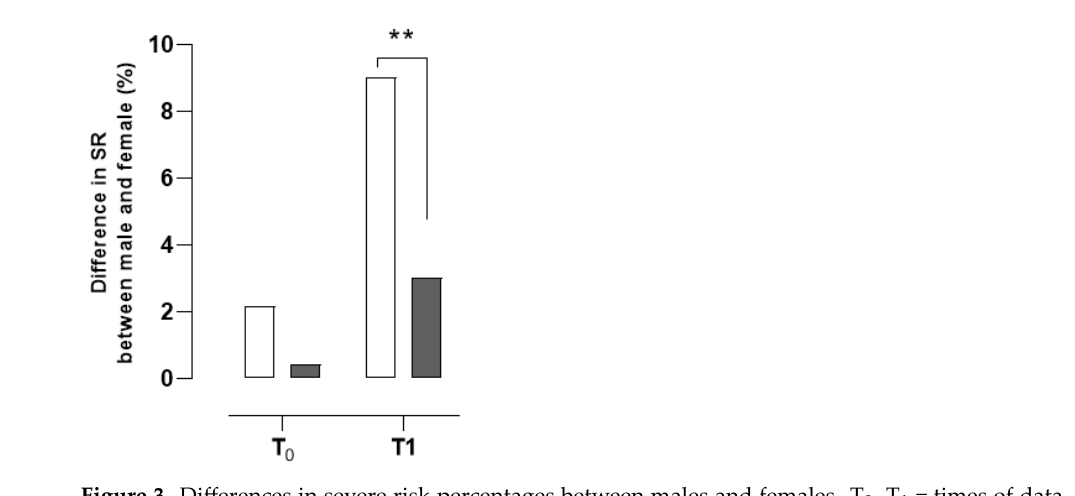
Figure 3. Differences in severe risk percentages between males and females. T 0 , T 1 = times of data collection and analysis. ■ = Female; □ = Male. ** p < 0.01; vs. Female .